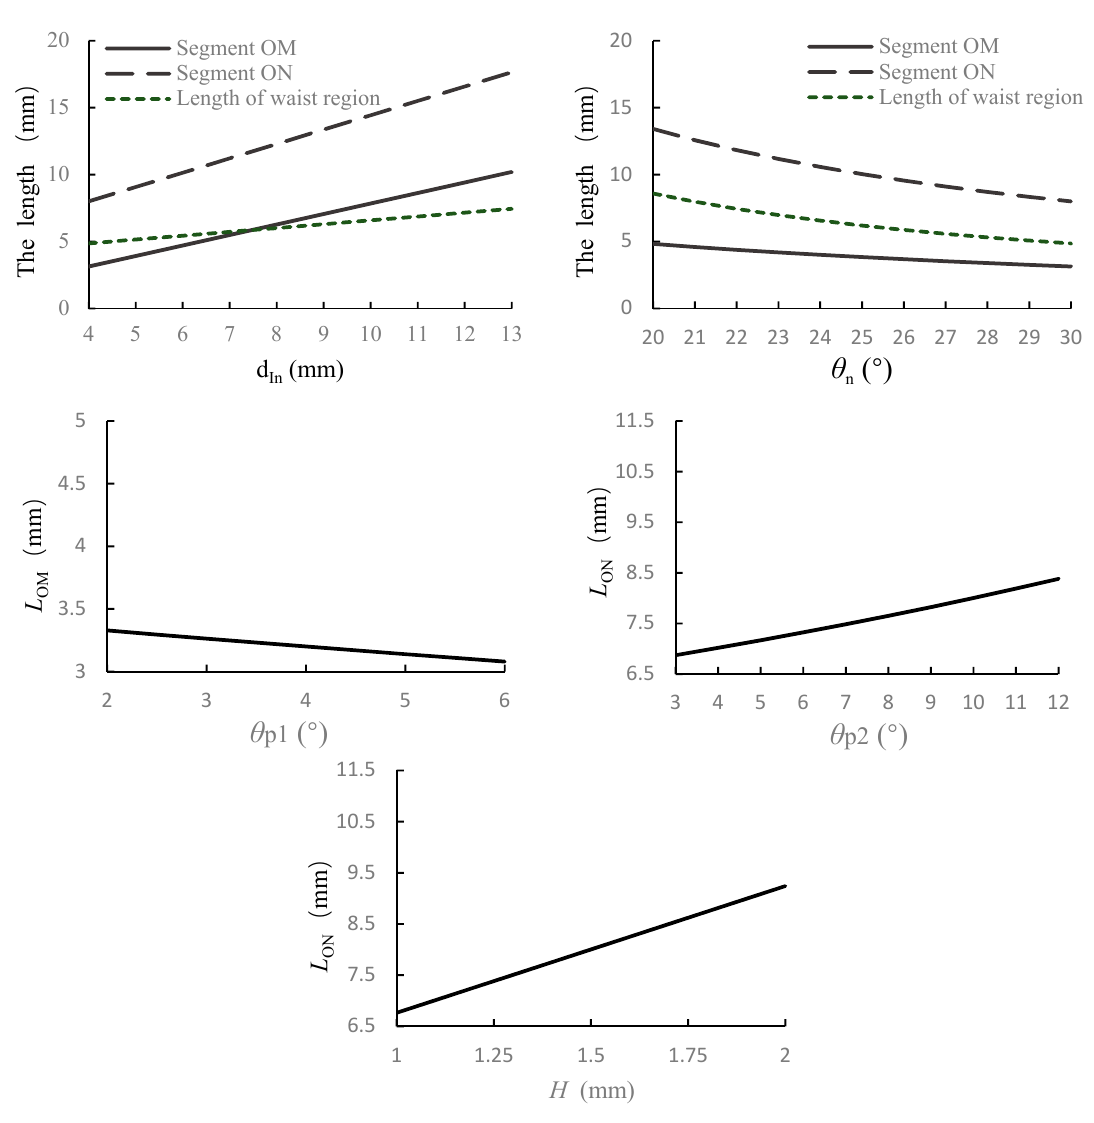
Figure 8. Geometric diagram of starting and ending positions of the waist zone.